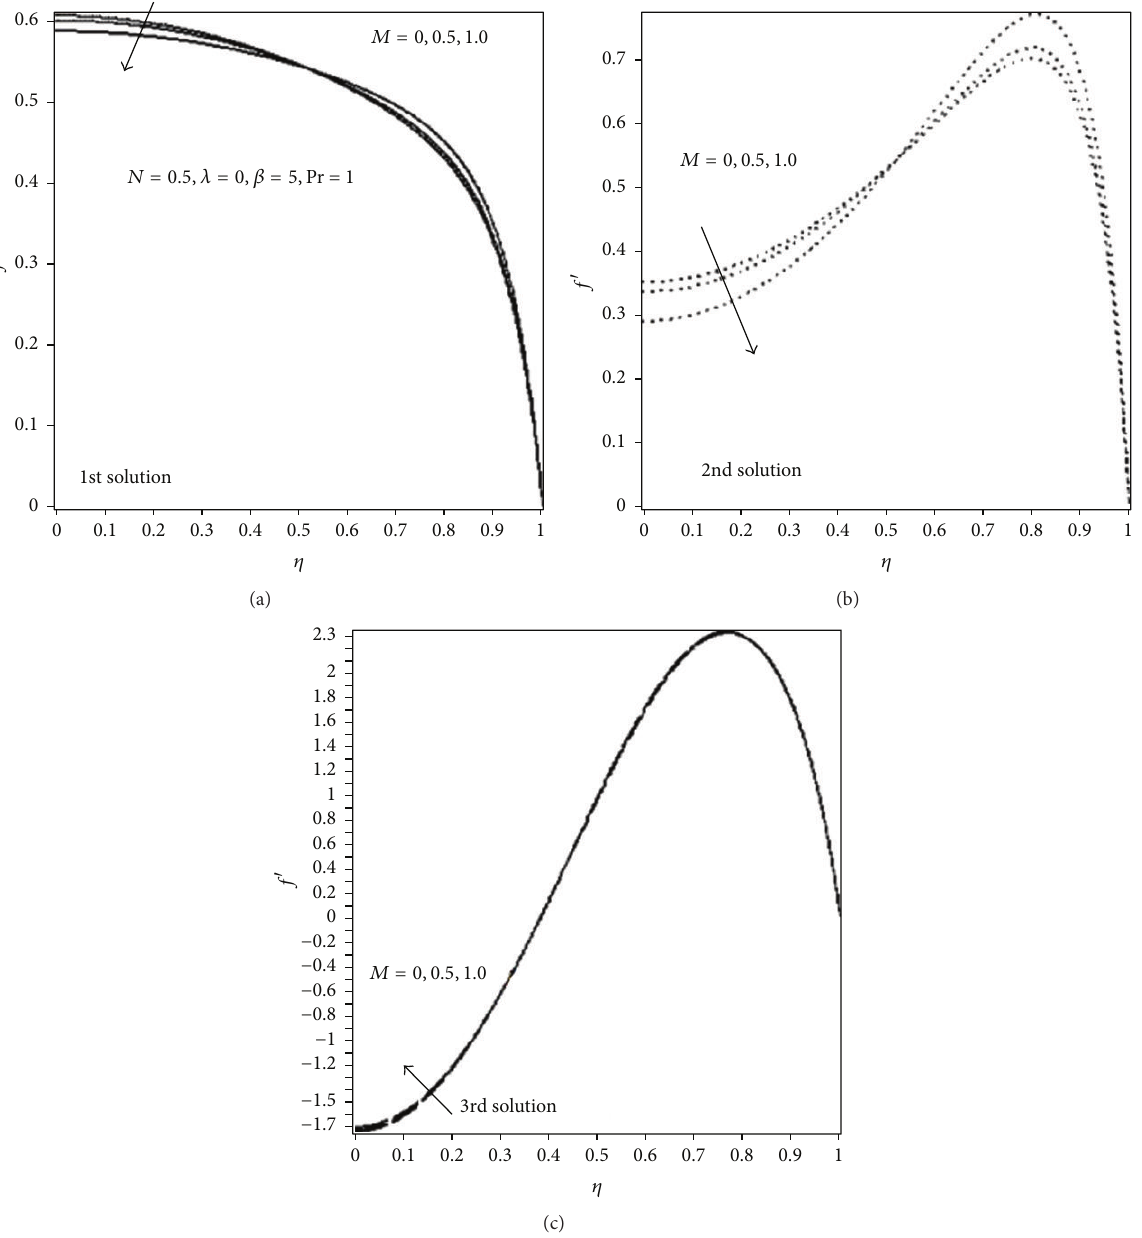
Figure 3: Effect of magnetic field 𝑀 on velocity profile 𝑓 󸀠 (𝜂)